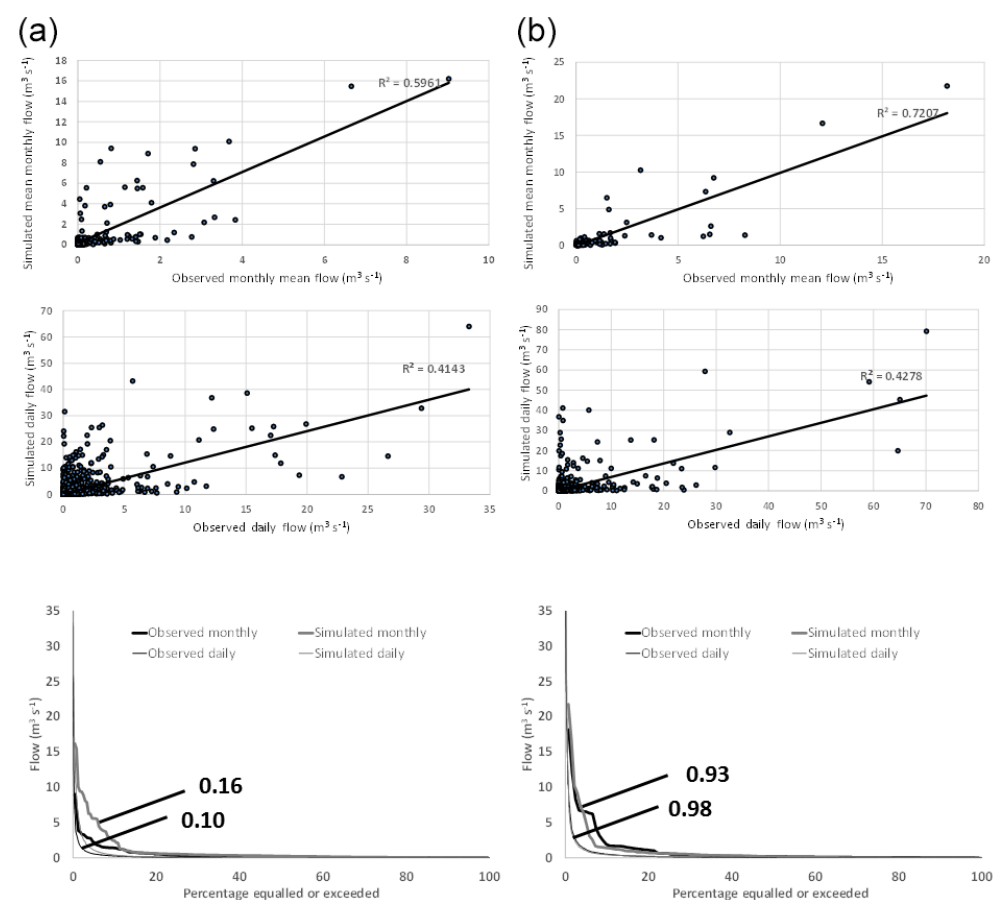
Figure 3. Observed and simulated flow for: (a) R20B and; (b) Yellowwoods on the Buffalo River in the Eastern Cape for the period 1971–2000. The top graph shows the X – Y scatter plot of the observed monthly time series versus WEAP (Sieber and Purkey, 2007) model simulations of monthly flow, the middle graph shows the X – Y scatter plot of the daily observed flow versus daily simulated flow generated through monthly-daily disaggregation within the WQSAM (Slaughter et al., 2012) model and the lower graph shows daily observed versus daily simulated and monthly observed versus monthly simulated flow represented as duration curves, with the Nash-Sutcliffe efficiencies (Nash and Sutcliffe, 1970) shown between each